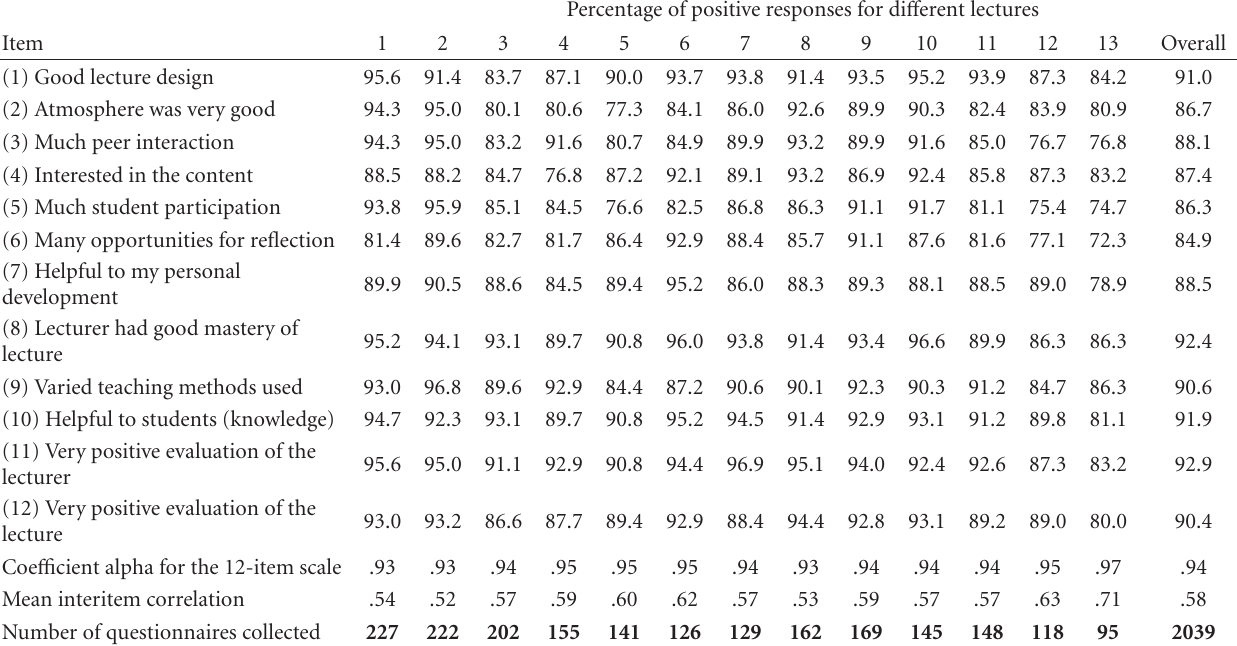
Table 1: Percentage findings based on subjective outcome evaluation of each lecture. Percentage of positive responses for di ff erent lectures